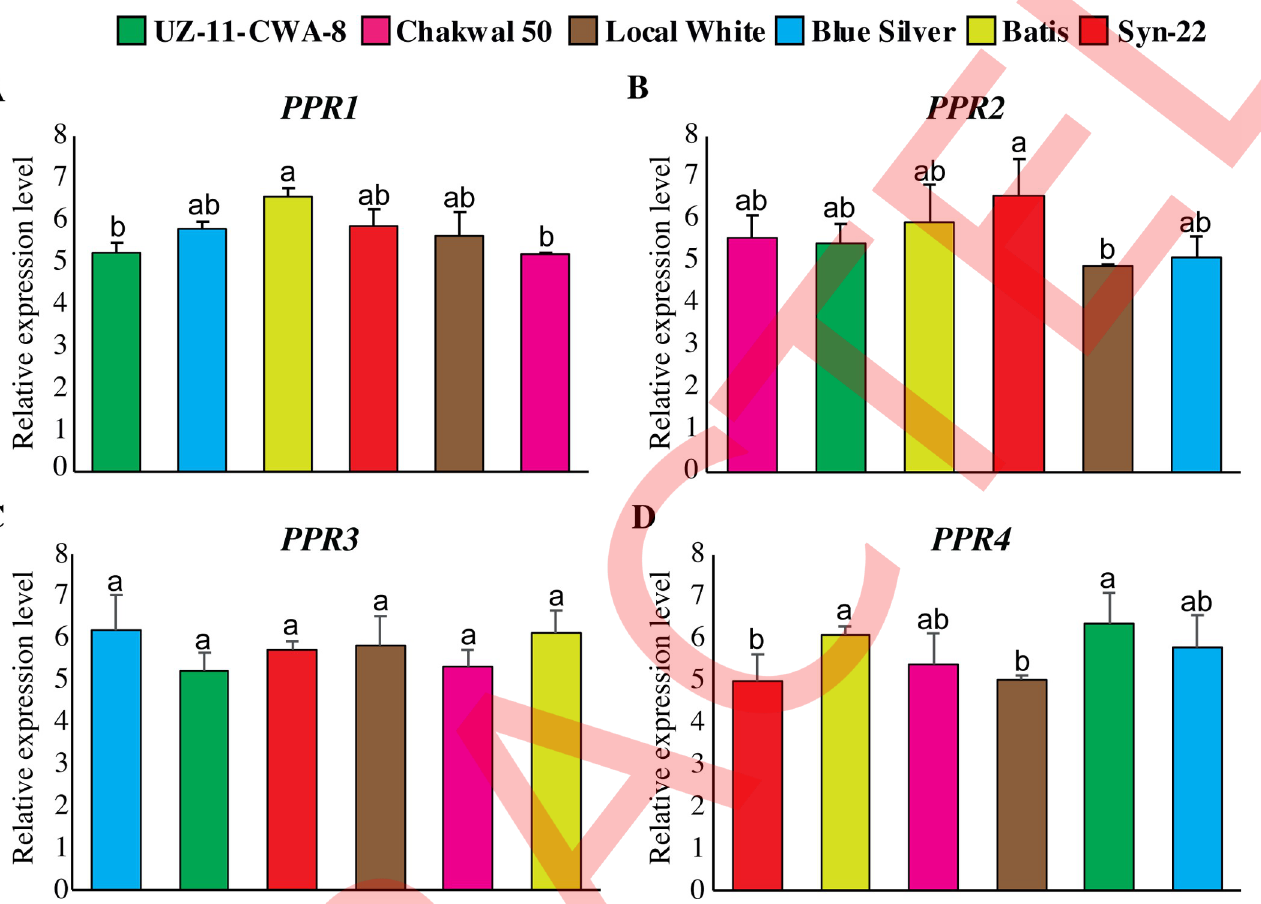
Fig 9. Measurements of gene expression of PPR by qRT-PCR. The relative gene expression of DEGs by qRT-PCR is represent by bars with standard errors in three independent experiments. Least Significant Difference (LSD) test was used. Different lowercase letters indicate significantly differences at P � 0.05.